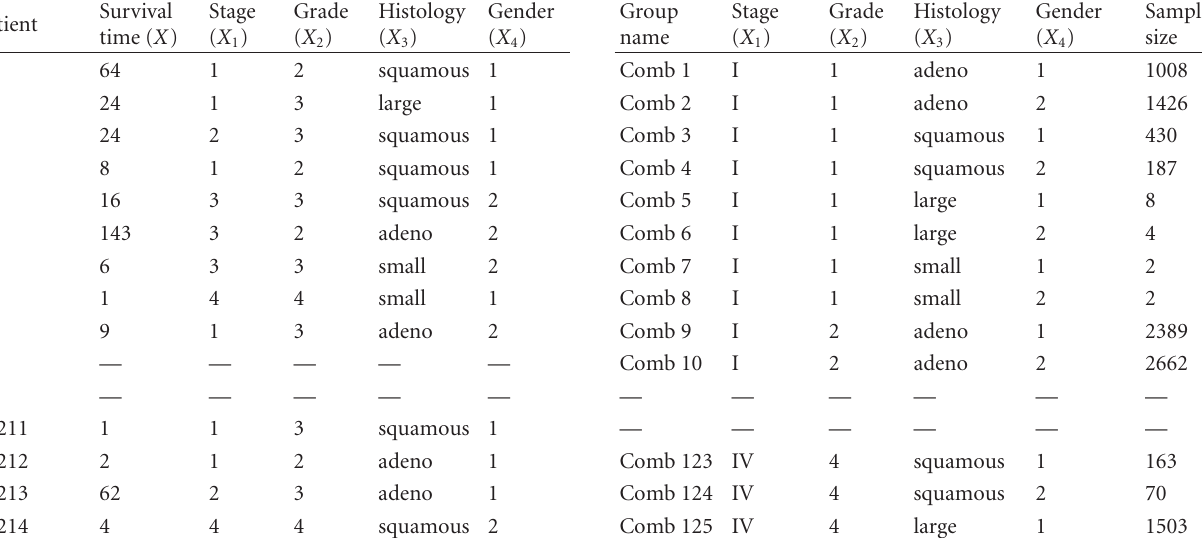
Algorithm 1: Ensemble algorithm of clustering of cancer data.